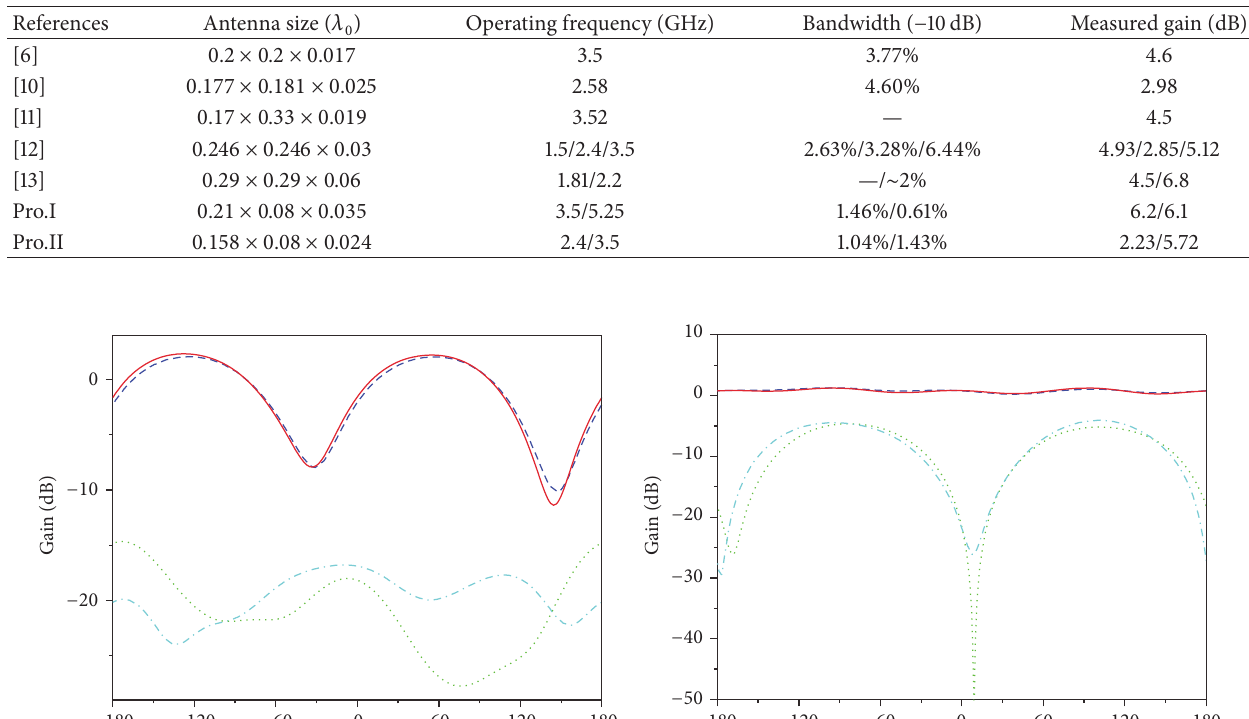
Table 2: Comparison of antenna performances between the literature and this work.